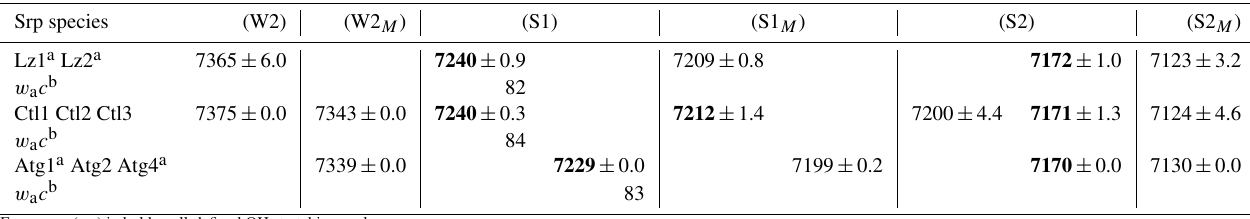
Table 3. First overtone ( 2v ) average frequency ( w e cm − 1 ) of OH stretching modes measured on decomposed NIR spectra in lizardite (Lz), chrysotile (Ctl), and antigorite (Atg) from serpentine (Srp) veins of the New Caledonian ophiolite. Srp